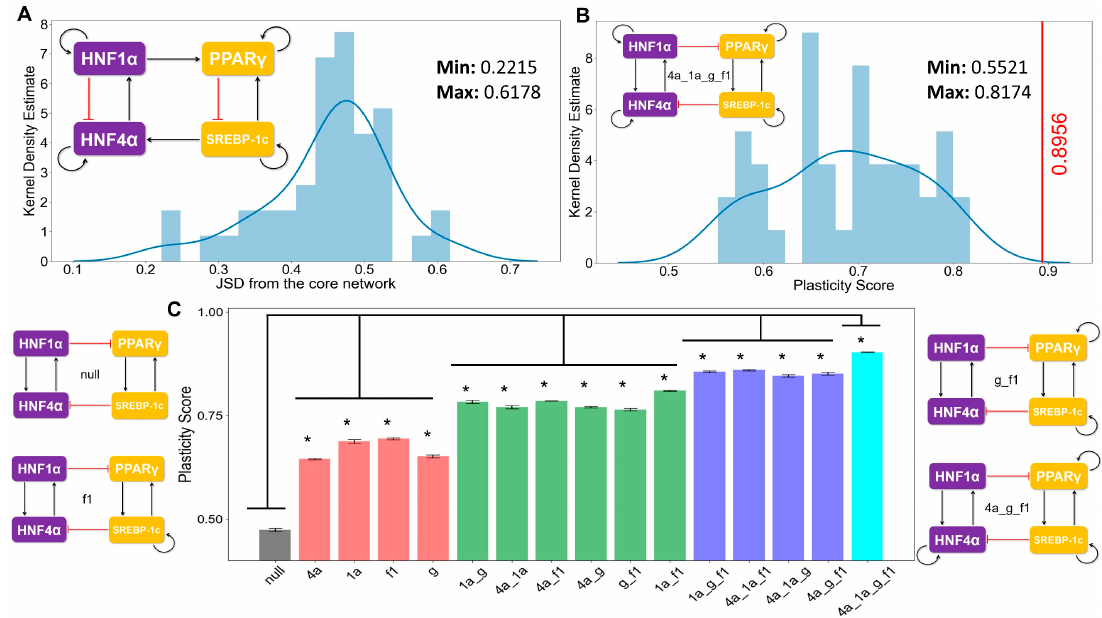
Figure 5. Proposed core regulatory module for NAFLD enables maximum plasticity. (A) Kernel density estimate plot with the histogram overlaying showing the distribution of the Jensen–Shannon distance (JSD) between the frequency of state distribution of the “hypothetical” randomized networks from the “wild type” core regulatory network. The maximum and the minimum values of the JSD observed are mentioned in the top right side in the figure. An example of a randomized network is shown at the top left corner. (B) Kernel density estimate plot with the overlaying histogram showing the distribution of the plasticity scores of the various random networks. The core regulatory circuit (codenamed 4a_1a_g_f1) is shown in the inset. The red vertical line indicates the plasticity score (=0.89) of the “wild type” core regulatory circuit, which is greater than all other “hypothetical” randomized networks. The maximum and minimum values of the JSD observed are mentioned in the top right side in the figure. Kernel density plots from two other independent RACIPE replicates are included in Figure S4A-D. (C) Bar plots showing the plasticity scores of the modified core regulatory networks with a varying number of direct self-activation loops. A few representative examples of the modified (i.e. “mutant”) networks and the corresponding codenames are drawn alongside (null indicates no self-activation loops; 4a, 1a, g, f1 denotes the network topology having self-activations on HNF4A, HNF1A, PPARG, and SREBF1, respectively). * indicates a significant difference of the plasticity scores (p-val < 0.05) when compared via the Student’s t-test with the plasticity of the null network. Error bars denote the standard deviation in plasticity scores calculated for three independent RACIPE replicates.